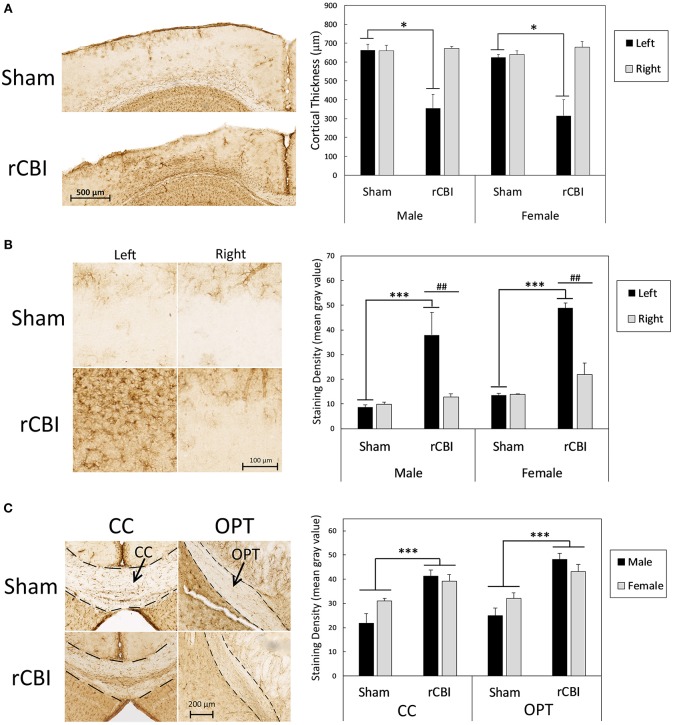
Cortical atrophy as measured by cortical thickness and astrogliosis following rCBI as evidenced by GFAP staining. Representative photomicrographs represent approximate median values. One year following injuries, injured mice had significantly thinner CTX at the injury site than sham-treated mice (A). Asterisks (*) in (A) represent a significant main effect of injury in the represented sex (Sham > rCBI; p < 0.05). There was also significantly increased astrogliosis in the perilesional CTX on the injured (left) side of the brain compared to the right side and compared to the left side of sham mice (B). Asterisks (***) in (B) represent a significant effect of injury on the left (injured) side of the brain (rCBI > Sham; p < 0.0001); pound signs (##) represent significant differences in staining density between the right (uninjured) and left (injured) sides of the brain in the represented sex (Left > Right; p < 0.01). GFAP staining density was significantly increased following injuries in white matter tracts, specifically the CC and OPT (C). Asterisks (***) in (C) represent a significant main effect of injury (rCBI > sham) in the represented brain region (p < 0.001). rCBI, repetitive concussive brain injury; GFAP, glial fibrillary acidic protein; CTX, cortex; CC, corpus callosum; OPT, optic tracts.